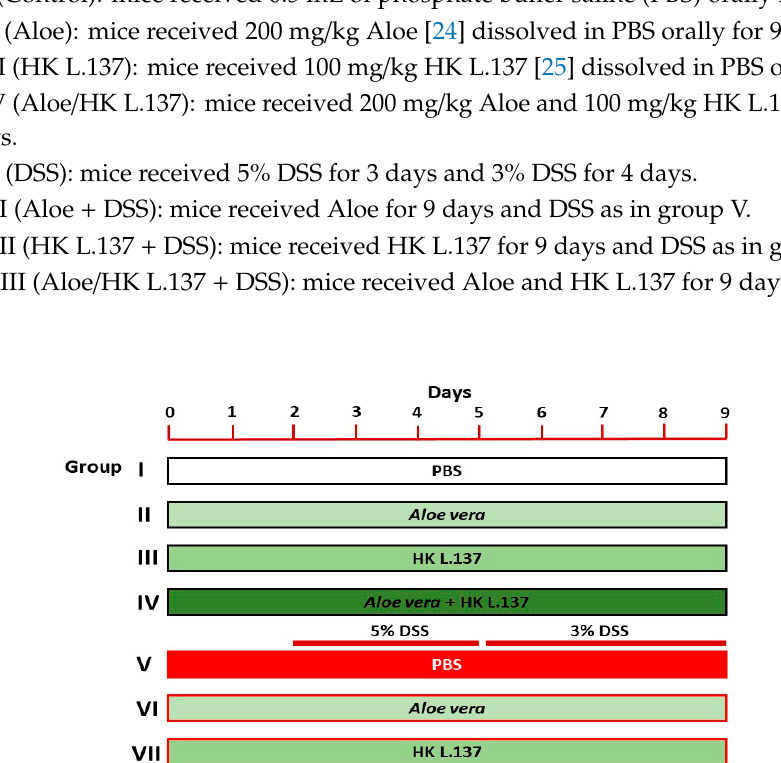
Table 1. Histopathological criteria of colitis grades.